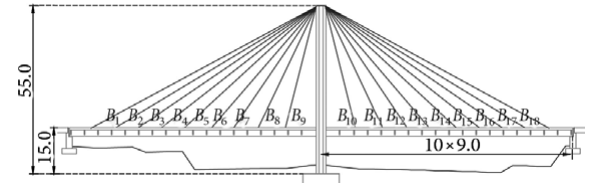
Fig. 7. Cable-Stayed bridge in Wuxi (dimensions in metres) Table 3. Mechanical properties of the Finite Element Model Element